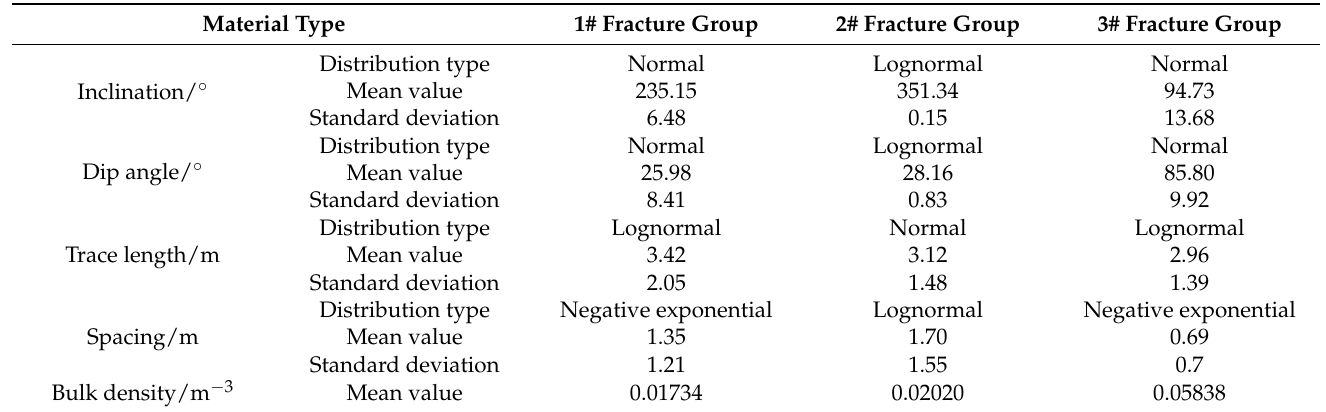
Table 2. Probability distribution and geometrical parameters of the fracture groups [24,27].